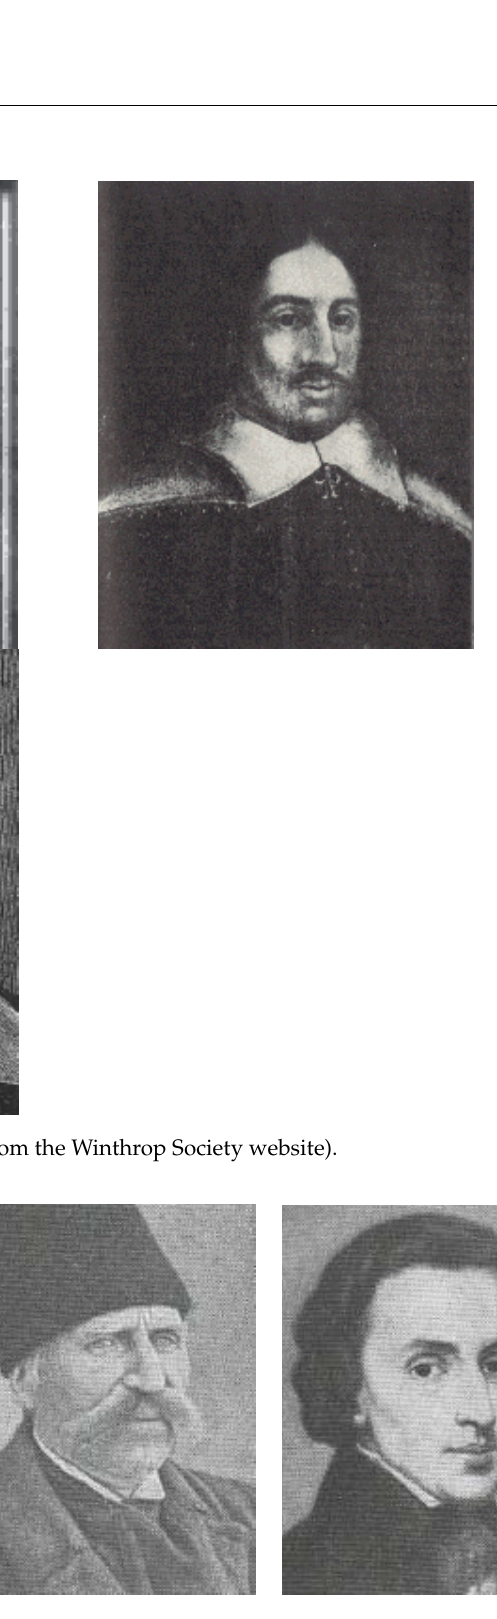
Figure A2. Persons of Dinaric Ancestry.